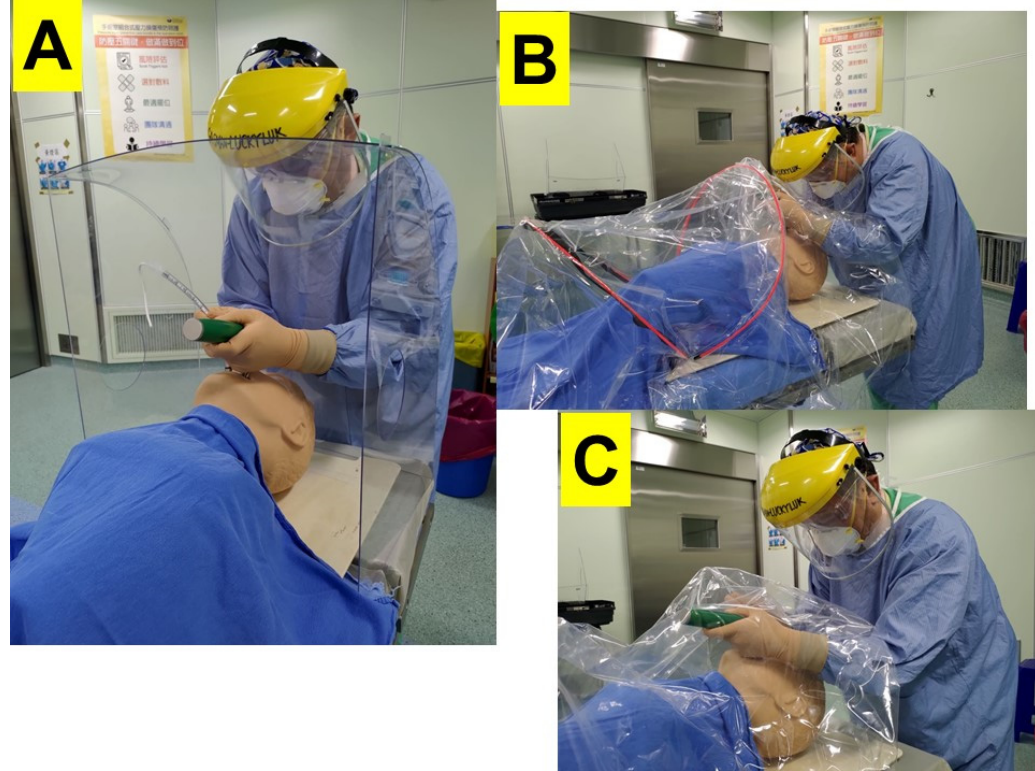
Figure 2. Various barrier systems utilized during performance of direct laryngoscopy and endotracheal intubation. ( A ) Rigid plastic box, ( B ) Plastic sheet with frame, ( C ) Plastic sheet without frame.